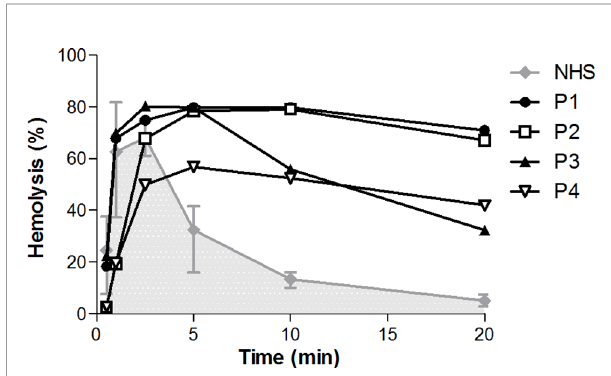
FIGURE 3 | Prolonged classical pathway convertase activity pro fi les in four patients. Classical pathway convertase activity was measured by incubating sensitized sheep erythrocytes with normal human serum (NHS) or with patient samples. Depicted are the activity pro fi les for patients P1, P2, P3, and P4, that tested positive for prolonged convertase activity as their top/t10 ratios were <1.6 in at least three measurements performed. Representative runs of these samples are shown. Data for NHS are given as the mean and range from the four experiments in which the positive patients were detected. The area under the NHS curve is indicated in grey. Hemolysis levels are presented as percentage of full lysis of erythrocytes in water.